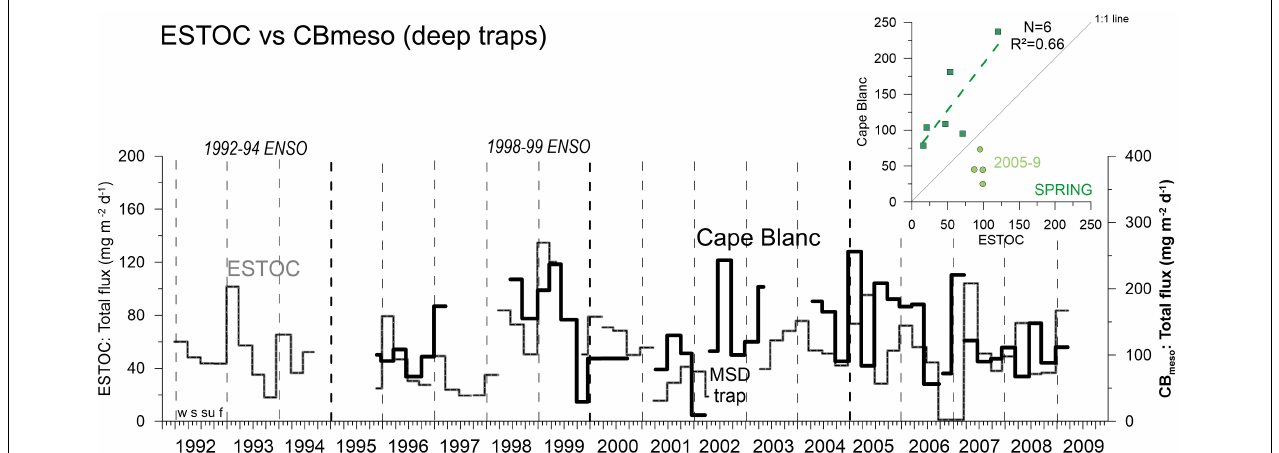
FIGURE 12 | Comparison of deep ocean total mass fluxes between the ESTOC site (including MSD traps) and the Cape Blanc mesotrophic site. Note the different scales for fluxes. The correlation coefficient between fluxes is highest for spring (upper right panel) for 1996–2004 ( R 2 = 0.66, N = 6) but the relationship is not significant ( p > 0.05). Between 2005 and 2009, data points show some scatter due to a shift in particle flux seasonality at ESTOC. Vertical hatched lines indicate years (with the four seasons winter = w, spring = s, summer = su, fall = f, starting on Jan. 1), thick hatched lines indicate the 5-year